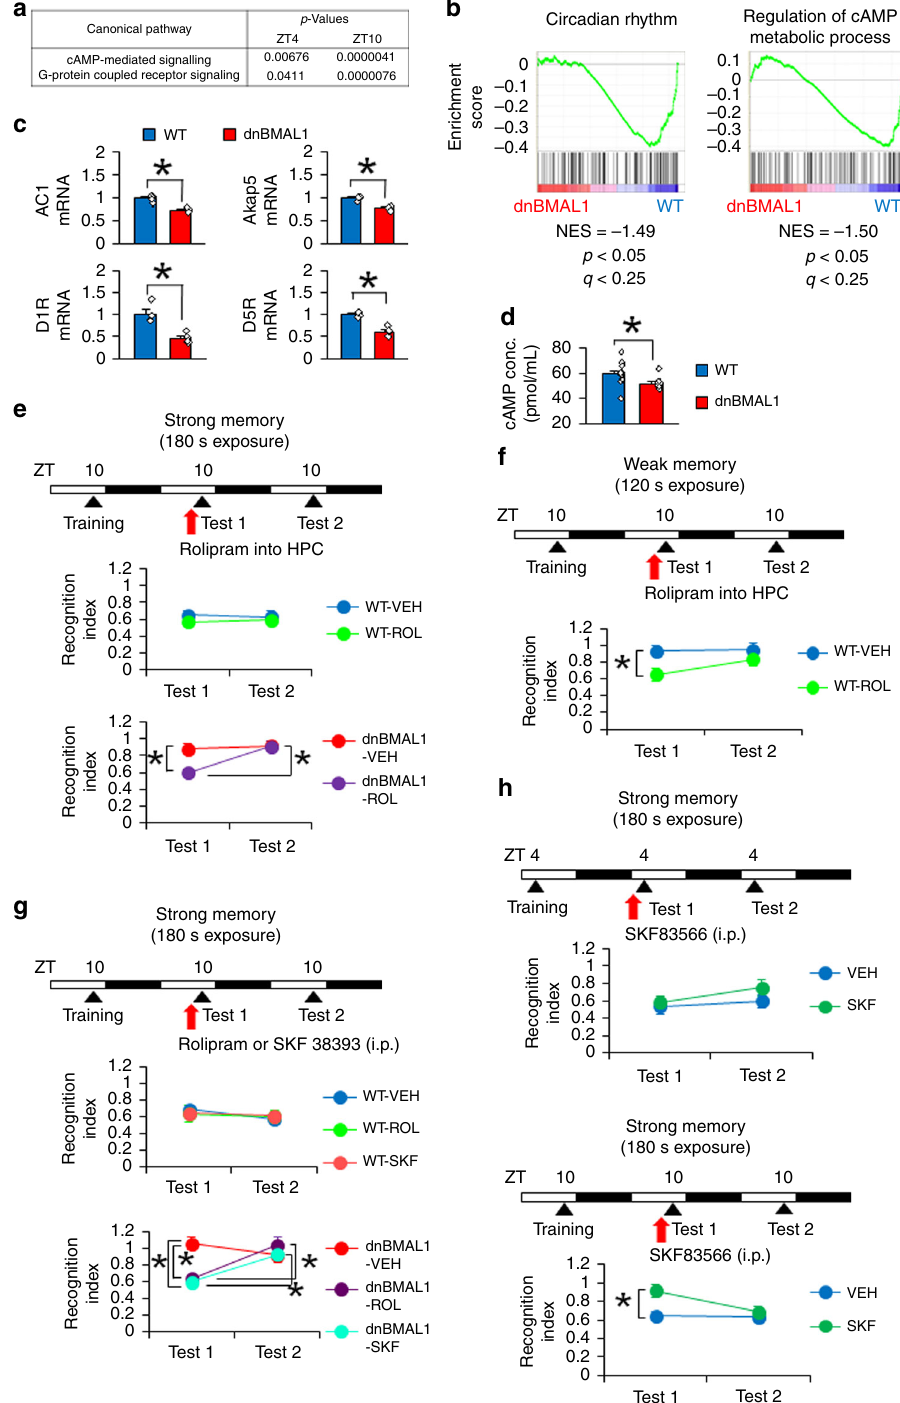
Fig. 5 Impaired Dopamine D1/5R-cAMP signal and its pharmacological rescues of memory retrieval de fi cits. a Changes in cAMP-mediated signaling and G-protein coupled receptor signaling in the hippocampus of dnBMAL1 mice (ingenuity pathway analysis). b Downregulation of gene set for circadian rhythm (left) and regulation of cAMP metabolic process (right) in the hippocampus of dnBMAL1 mice at ZT10 (Enrichment plot). NES normalized enrichment score. a , b All groups ( n = 3). c , d Reduced AC1, AKAP5, D1R, and D5R mRNAs ( c ) and cAMP ( d ) levels in the hippocampus of dnBMAL1 mice at ZT10. The graph represents fold changes compared to the expression levels in WT ( c ). e – h Experimental designs at the top of each panel. Retrieval is tested twice (Tests 1 and 2) at ZT10 following strong ( e , g , h ) or weak ( f ) training at ZT10. Dorsal hippocampal micro-infusion ( e , f ) or systemic injection ( g , h ) of drug at 30 min before Test 1. Rescues of impaired retrieval by hippocampal rolipram in dnBMAL1 ( e , strong training) and WT mice ( f , weak training) and by systemic SKF38393 (D1/5R agonist) or rolipram injection at Test 1 in dnBMAL1 mice ( g ). Impaired retrieval by systemic SKF83566 injection (D1/5R antagonist) in WT mice ( h , Supplementary Fig. 5). HPC hippocampus, VEH vehicle. All values are mean ± SEM. Individual data points are displayed as dots. * p < 0.05 as determined by three-way ( e , g ), two-way ( f , h ), or one-way ( c , d ) ANOVA with post hoc test. The results of the statistical analyses are presented in Supplementary Table 2. Source data are provided as a source data fi